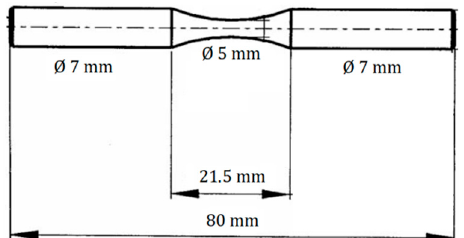
Figure 1. The shape and size of the samples for fatigue experiments.